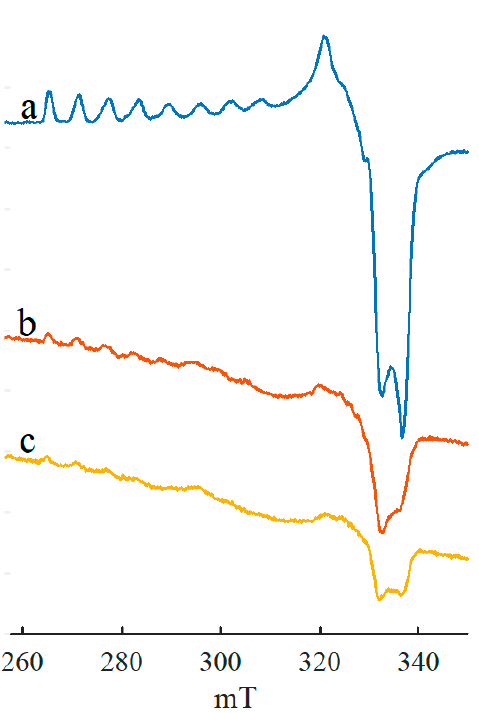
Figure 4. EPR spectra of the Co(acac) 2 –Red catalytic system formed in an argon atmosphere, other conditions being equal, where ( a ) Red = AlEt 3 , ( b ) Red = Li- n -Bu and ( c ) (PhCH 2 )MgCl. Spectrum ( a ) was taken from [77].